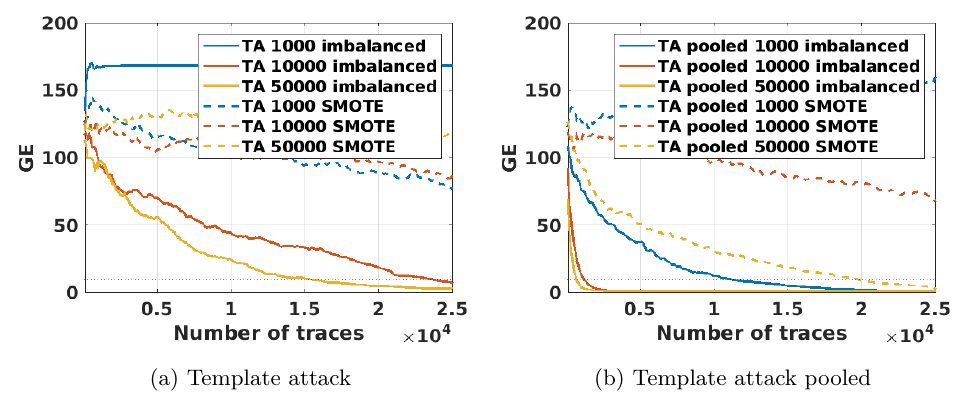
Figure 4: Guessing entropy for imbalanced and SMOTE on AES_HD, template